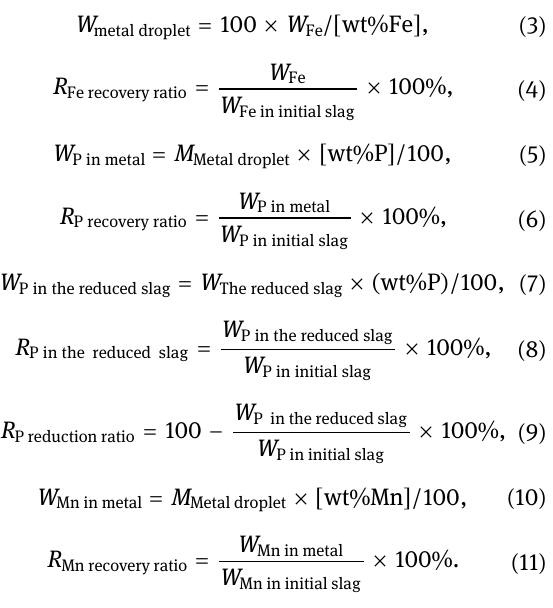
where ( wt%CaO ) and ( wt%FeO ) indicate the mass fraction of CaO and FeO after the experiment; W the reduced slag and W indicate the masses of the residual slag and the Fe ) after the experiment; W CaOInitial and W CaOInitial metallic iron ( M Fe indicate the masses of CaO and Fe ( element ) in the initial and M indicate the molecular experimental slag; and M FeO Fe weight of FeO and the atomic weight of Fe. Based on the above calculations by equations ( 1 ) and ( 2 ) and the mass fraction of Fe, P, and Mn in metal dro - plets and slag acquired after the experiment, the distribu - tion of these elements can be obtained. As shown in equations ( 3 ) – ( 11 ) , [ wt%Fe ] , [ wt%P ] , and [ wt%Mn ] indi - cate the mass fractions of Fe, P, and Mn in metal droplet acquired after the experiment, respectively; wt%P indi - cates the mass fraction of P in the reduced slag acquired ( g ) indicates the mass of after the experiment; W metal droplet , W the metal droplet after the experiment; W Fe in initial slag P ( g ) indicate the mass of , and W Mn in initial slag in initial slag Fe, P, and Mn in the initial experimental slag, respec - indicates tively, as shown in Table 1; W P in the reduced slag and W the mass of P in the reduced slag; W P in metal Mn in indicate the mass of P and Mn in the metal droplet metal after the experiment, respectively; R , R Fe recovery ratio P , and R indicate the recovery ratios Mn recovery ratio recovery ratio of Fe, P, and Mn after the experiment, respectively; R P in ( mass fraction, % ) indicates the ratio of the the reduced slag residual phosphorus in the reduced slag to phosphorus ( mass in the initial experimental slag; R P reduction ratio fraction, % ) indicates the reduction ratio P in the initial experimental slag through the experiment.